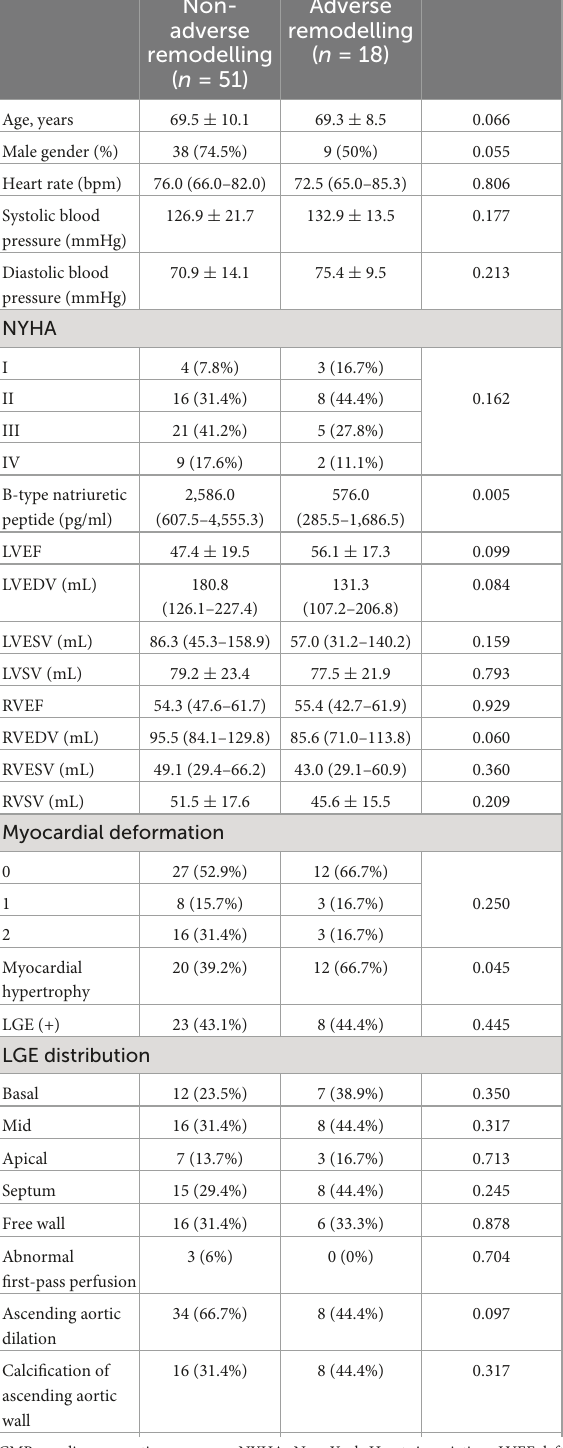
TABLE 2 Comparison of clinical and CMR features between adverse and non-adverse subgroups. Non-